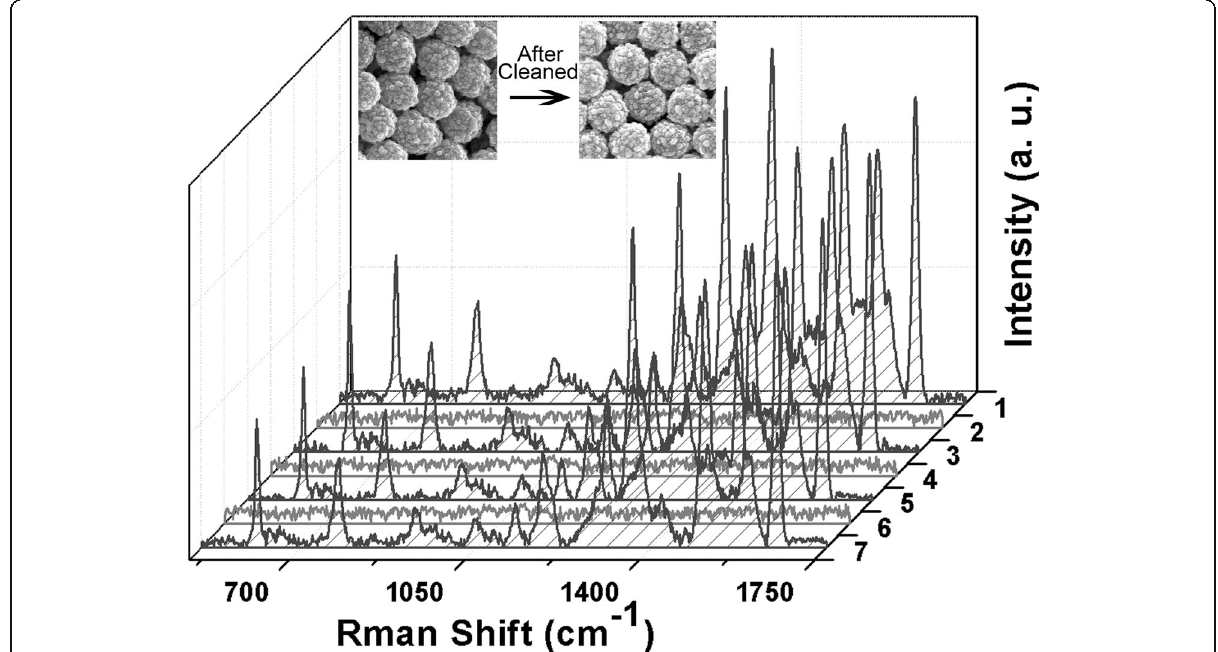
Fig. 6 The recyclability of SERS substrate assembled by FOSTA composite